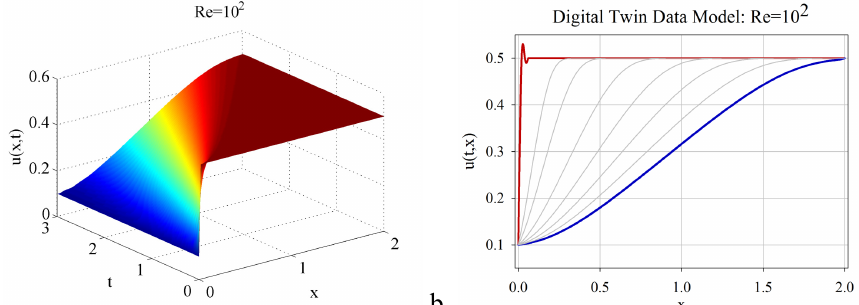
Figure 10. Solution of the digital twin data model in the case of experiment Re = 10 2 : ( a ) 3D view; ( b ) Projection view of the shock wave.